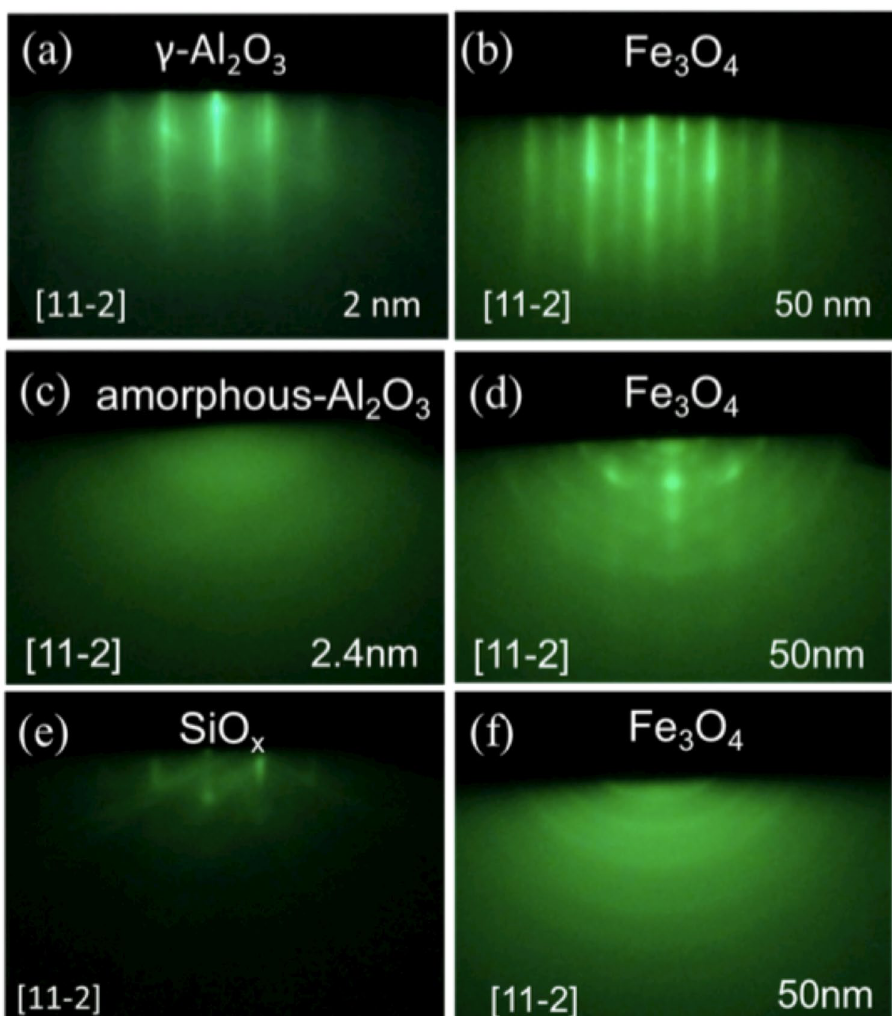
Figure 2. RHEED patterns: ( a ) γ -Al 2 O 3 and ( b ) Fe 3 O 4 film on γ -Al 2 O 3 in EPI, ( c ) amorphous-Al 2 O 3 and ( d ) Fe 3 O 4 on amourphous-Al 2 O 3 in AMO, ( e ) Si surface before depositing Fe 3 O 4 , and ( f ) Fe 3 O 4 on Si substrate in